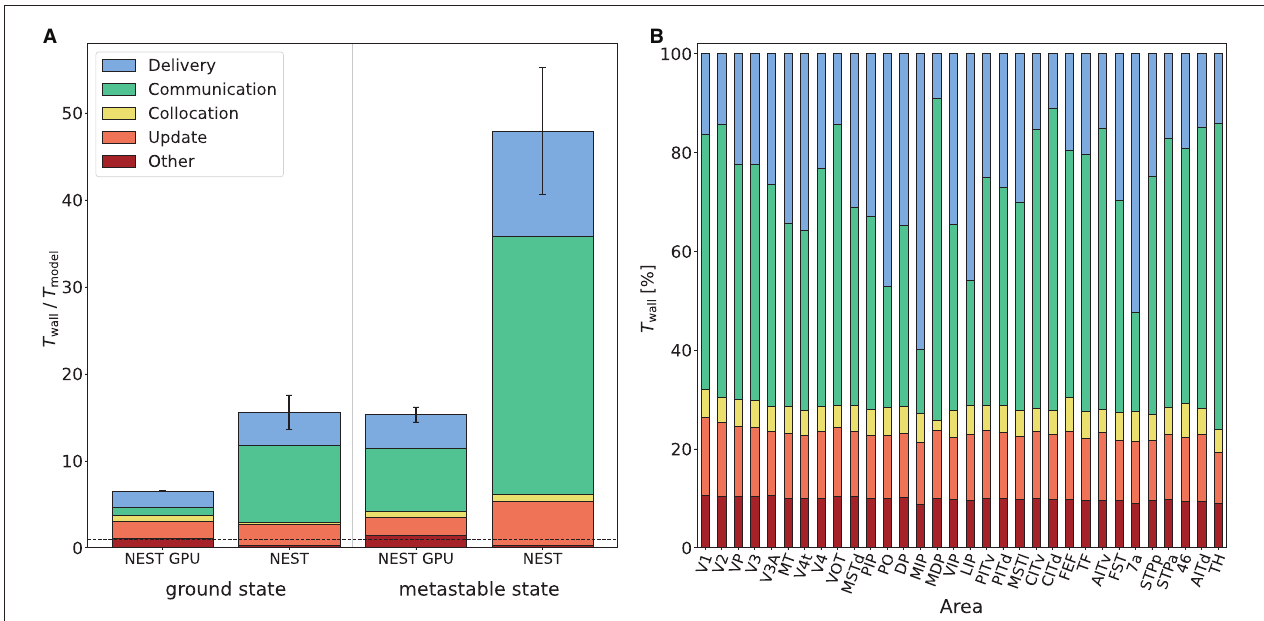
FIGURE 8 | Contributions to the simulation time of the multi-area model. (A) Contributions to the simulation time in the ground state and the metastable state for NEST and NEST GPU measured with the real-time factor. Error bars show the standard deviation of the overall performance across 10 simulations with different random seeds. The plot shows the performance obtained by NEST GPU and NEST in the 32-node configuration. NEST simulations were performed on JURECA-DC using 8 MPI processes per node and 16 threads per task, whereas NEST GPU simulations were performed on JUSUF using one MPI process per node and 8 threads per task. The black dashed line indicates the biological time. (B) Relative contributions to the simulation time of the multi-area model in the metastable state for every area (i.e., for every MPI process) in a NEST GPU